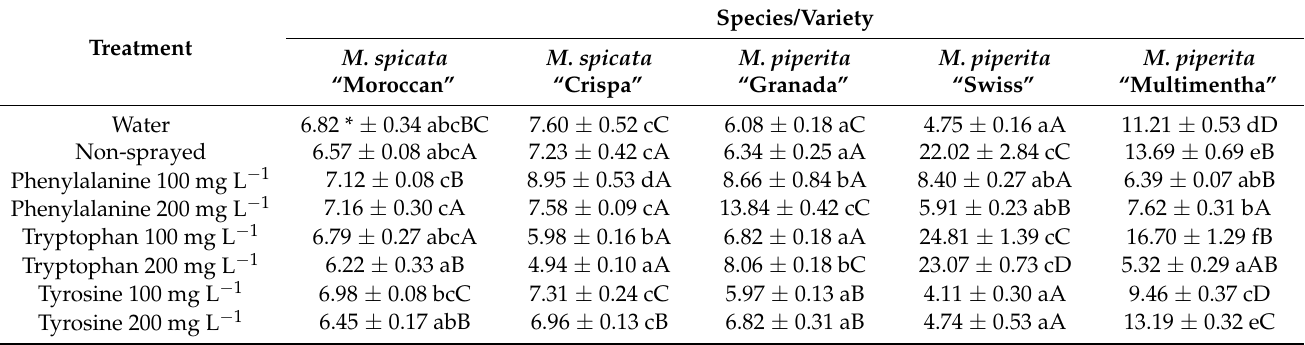
* Means ± standard deviations marked with different upper letters (A, B, C . . . ) in the rows are significant different at p < 0.05; Means ± standard deviations marked with different lower letters (a, b, c . . . ) in the columns are significant different at p < 0.05. Table 2. Benzoic acid content in mints influenced by foliar application of amino acids, mg 100 g − 1 DM in 2017–2018. Species/Variety Treatment